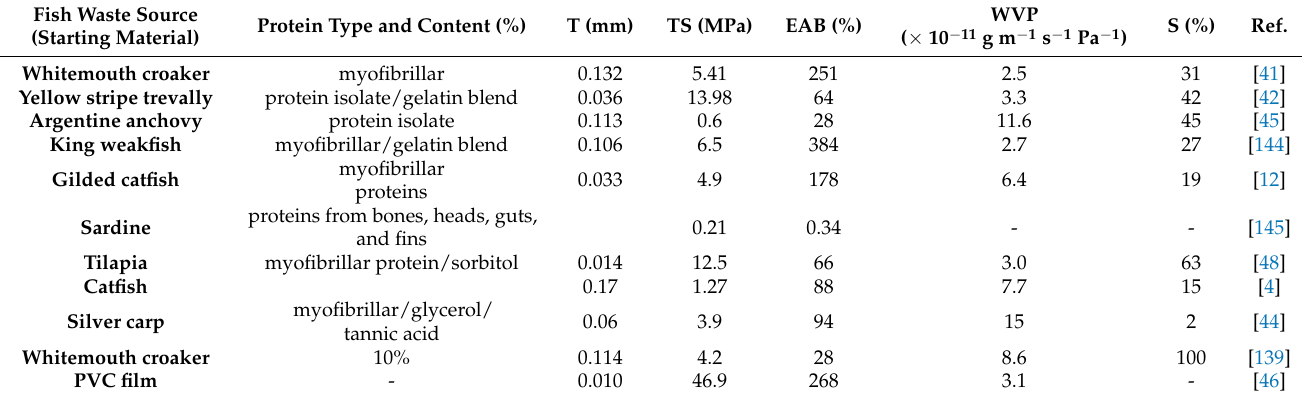
Table 1. Properties of bio-based and biodegradable polymer films derived from muscle proteins. Fish Waste Source Protein Type and Content (Starting Material)